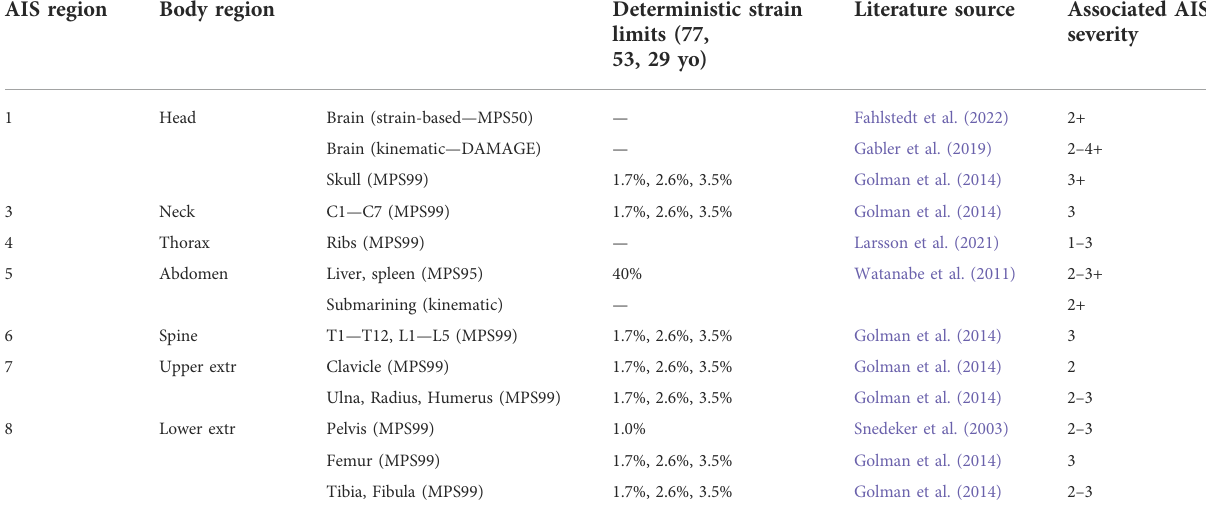
TABLE 2 Injury metrics for the HBM simulations. Strain limits for cortical bones are provided for the ages of 77, 53, and 29